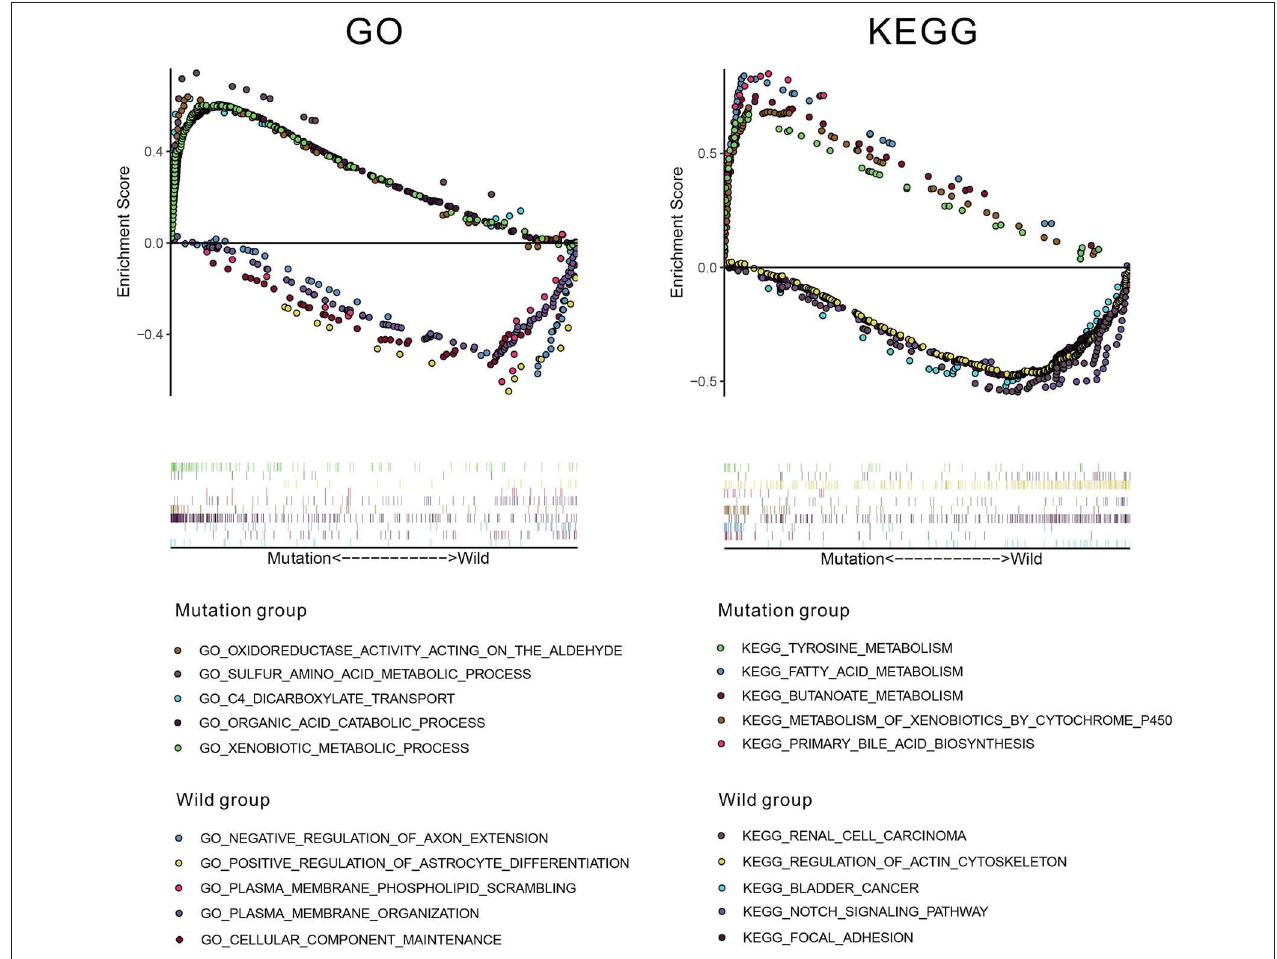
FIGURE 8 | The results of gene set enrichment analysis (GSEA) based on Gene Ontology (GO) and Kyoto Encyclopedia of Genes and Genomes (KEGG) databases.